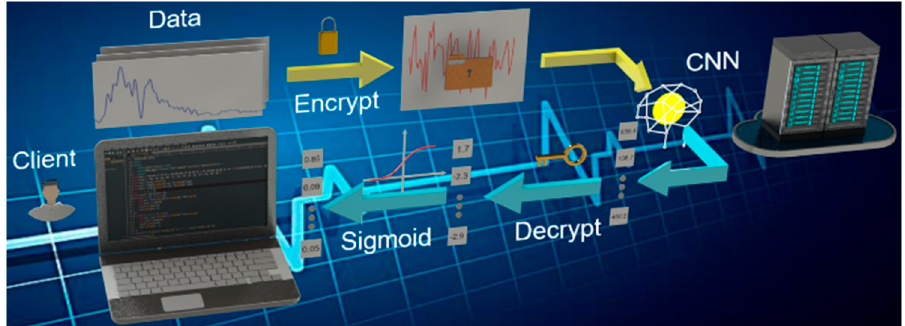
Figure 4. Secure application in client-server model. Possessing private data waiting for identification, client encrypted his plaintext using public key for ciphertext, which was then received by the server. Without decrypting it, the server performed calculations of CNN with homomorphic encryption (HE) backend directly and sent the decrypted results to the client, who uncovered results with his secure